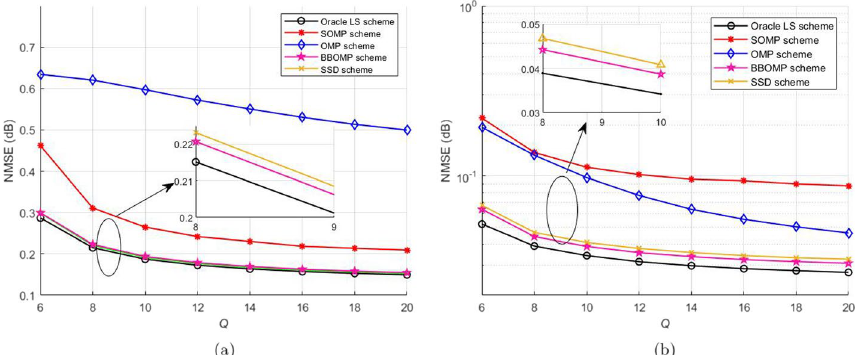
Fig. 7 The NMSE performance of different schemes versus the number of instants Q . a . SNR SNR